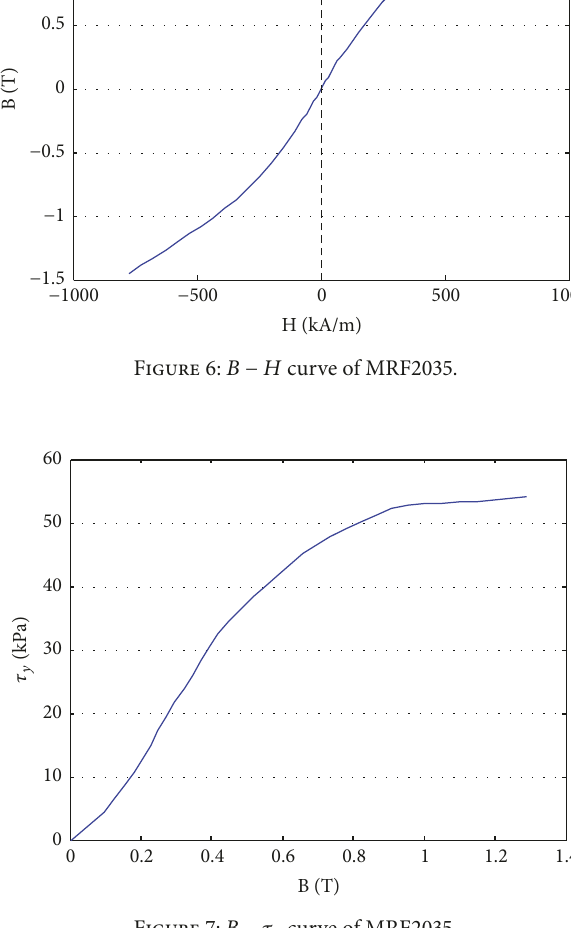
Figure 7: 𝐵 − 𝜏 𝑦 curve of